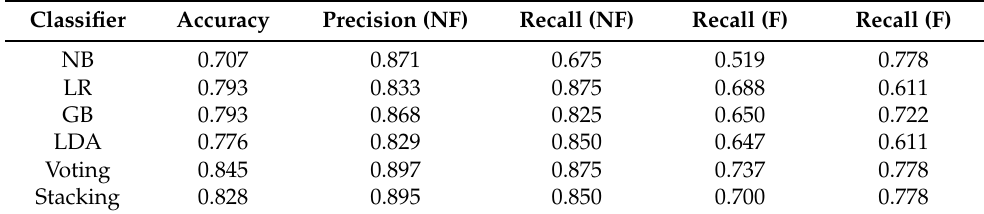
Table 11. Cross validation accuracy for the joint HV, LV